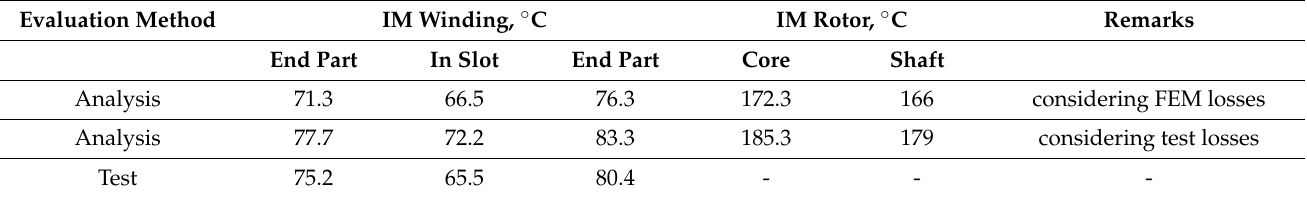
Table 8. Temperature distribution